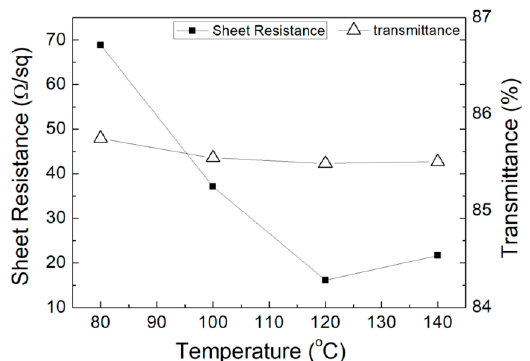
Figure 5. Relationship among the sheet resistance of the printed AgNWs patterns, transmittance and treatment temperature.